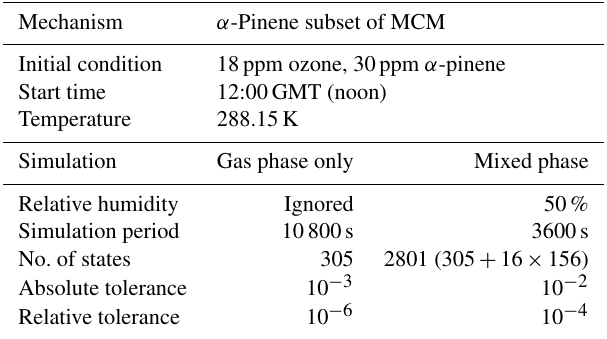
Table 1. Initial conditions and solver